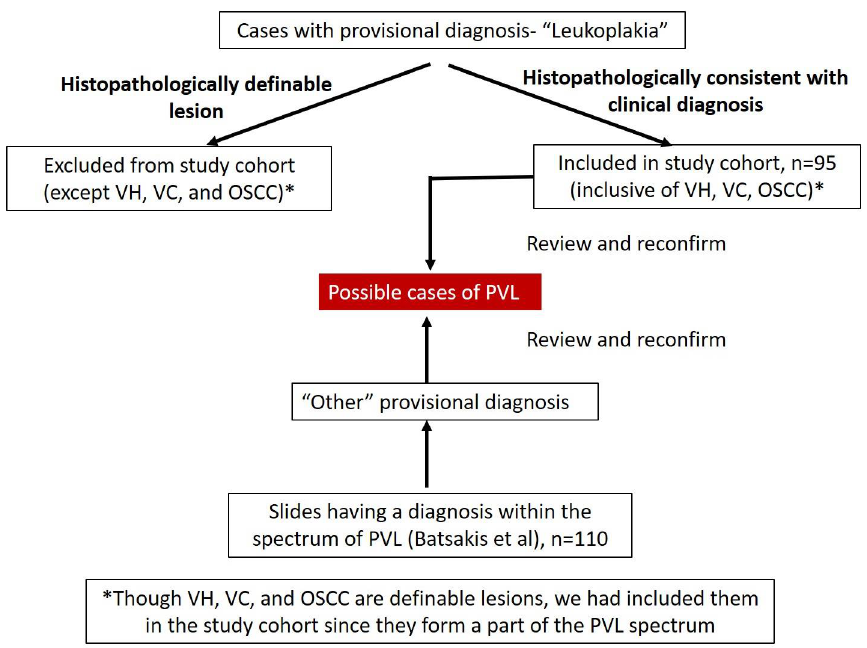
Figure 1. Summary of the methodology employed in the selection of cases. The histopathological spectrum of PVL includes simple hyperkeratosis, varying grades of epithelial dysplasia, verrucous hyperplasia (VH), verrucous carcinoma (VC), papillary squamous cell carcinoma (PSCC), and oral squamous cell carcinoma (OSCC) with intermediate stages (Figure 2).